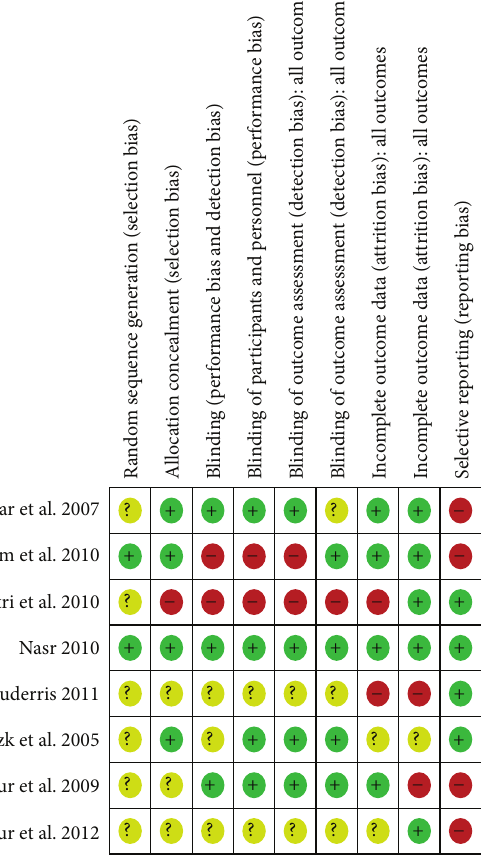
190 women) with considerable heterogeneity. Six